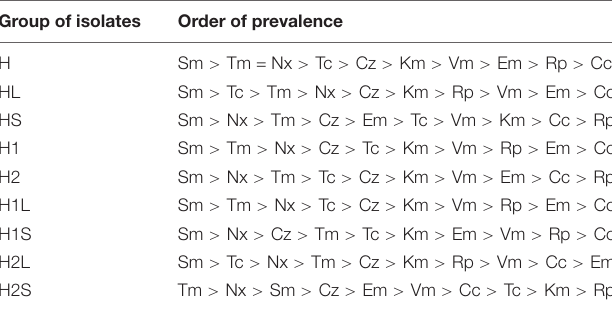
TABLE 2 | Order of prevalence of resistance to individual antibiotics in the indicated groups of isolates. Group of isolates Order of